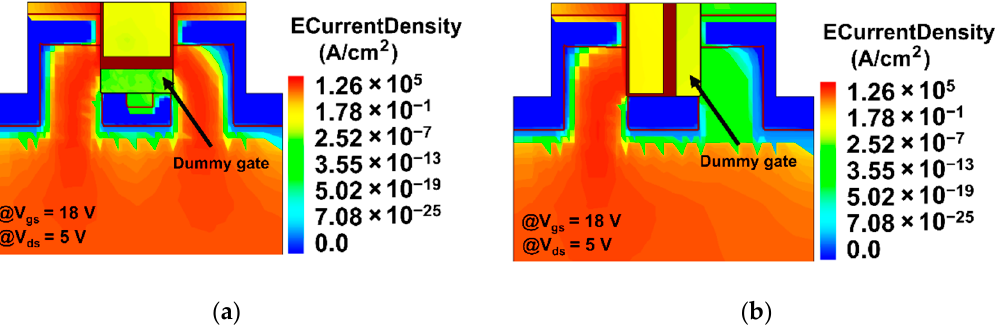
Figure 4. Comparison of the on-state characteristics of DT-MOSFET and proposed DTMCD- MOSFET.